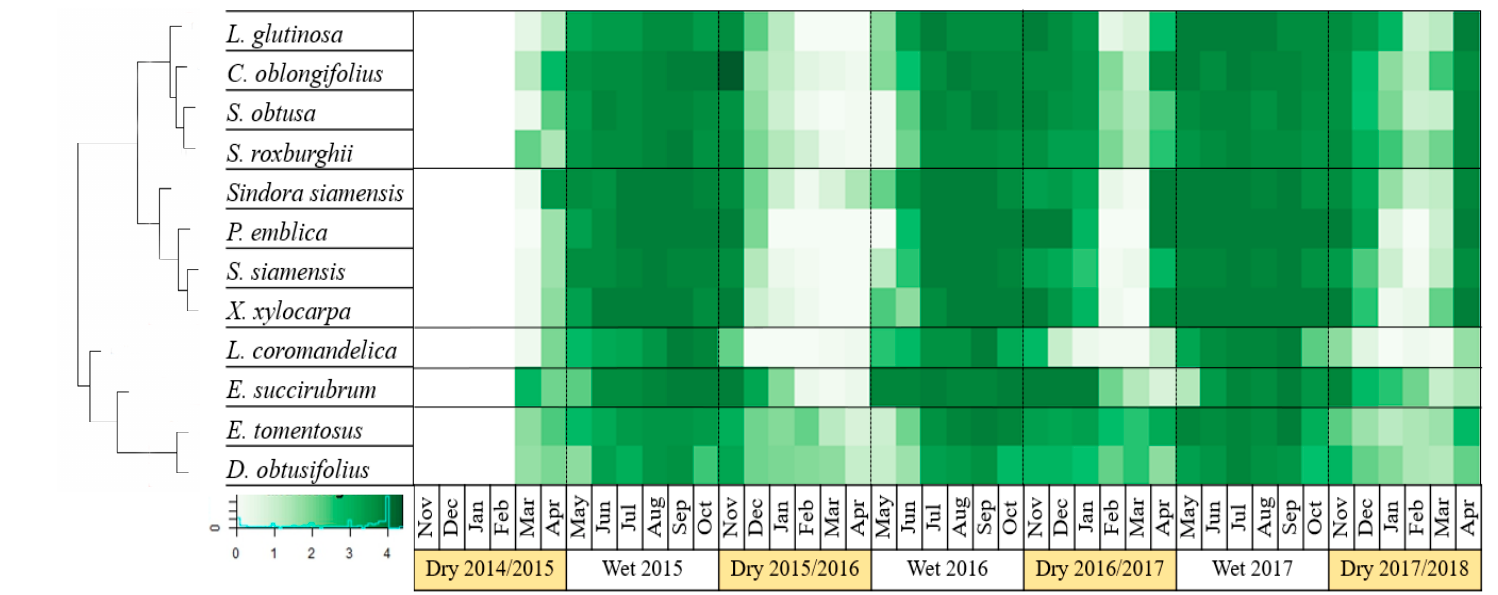
Figure 3. Phenological pattern of mature leaves of 12 species clustered into five groups (C1–C5) between March 2015–April 2018 (the black lines mark the separation between the different clusters of species based on their phenological patterns), the color gradient in the legend defined the score of mature leaf (0–4) in the canopy. The dark green indicates the full leaf canopy, while the light green and the white colors indicate less leaves and no leaves on the canopy, respectively.